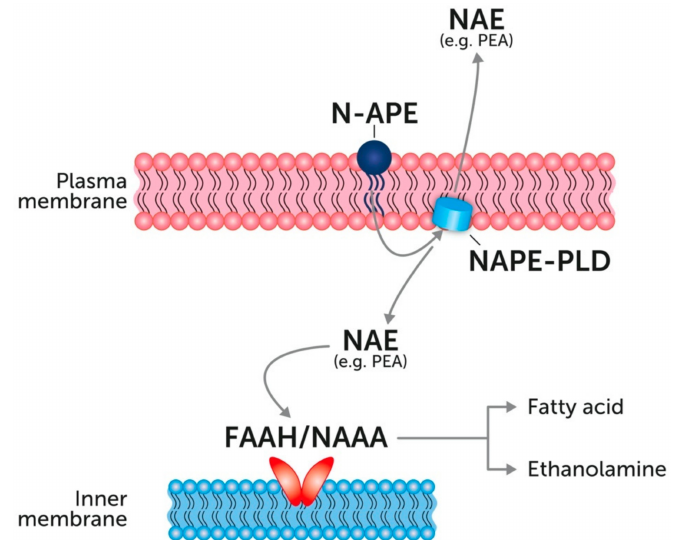
Figure 2. The main biosynthetic and degradative pathways of N-acyl ethanolamines (NAEs). Modified from [56]. NAE: N-acyl ethanolamines; NAPE-PLD: N-acyl phosphatidylethanolamine phospholipase D; NAPE: N-acyl phosphatidylethanolamine; FAAH: fatty acid amide hydrolase; NAAA: N-Acylethanolamine acid